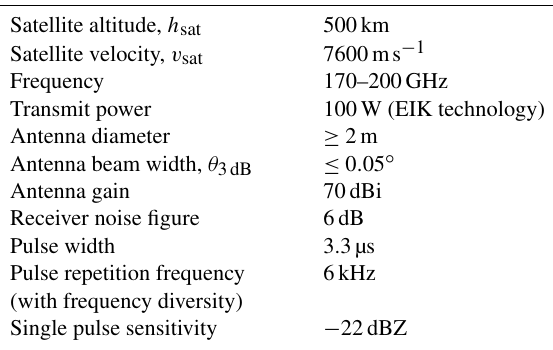
Figure 2. Attenuation coefficient for ice crystals with different mass-weighted maximum particle diameters as indicated in the leg- end for the frequency range of interest for this study. Exponential size distributions have been assumed. Dashed and continuous lines correspond to the model “A; LWP = 0 . 1kgm − 2 ” from Leinonen and Szyrmer (2015) and to the Hogan and Westbrook (2014) model, respectively. The grey-shaded area corresponds to the attenuation coefficient for supercooled liquid clouds for temperatures in the range between − 30 and 0 ◦ C. Water refractive index is computed according to the Ellison07 model; see Turner et al. (2016).